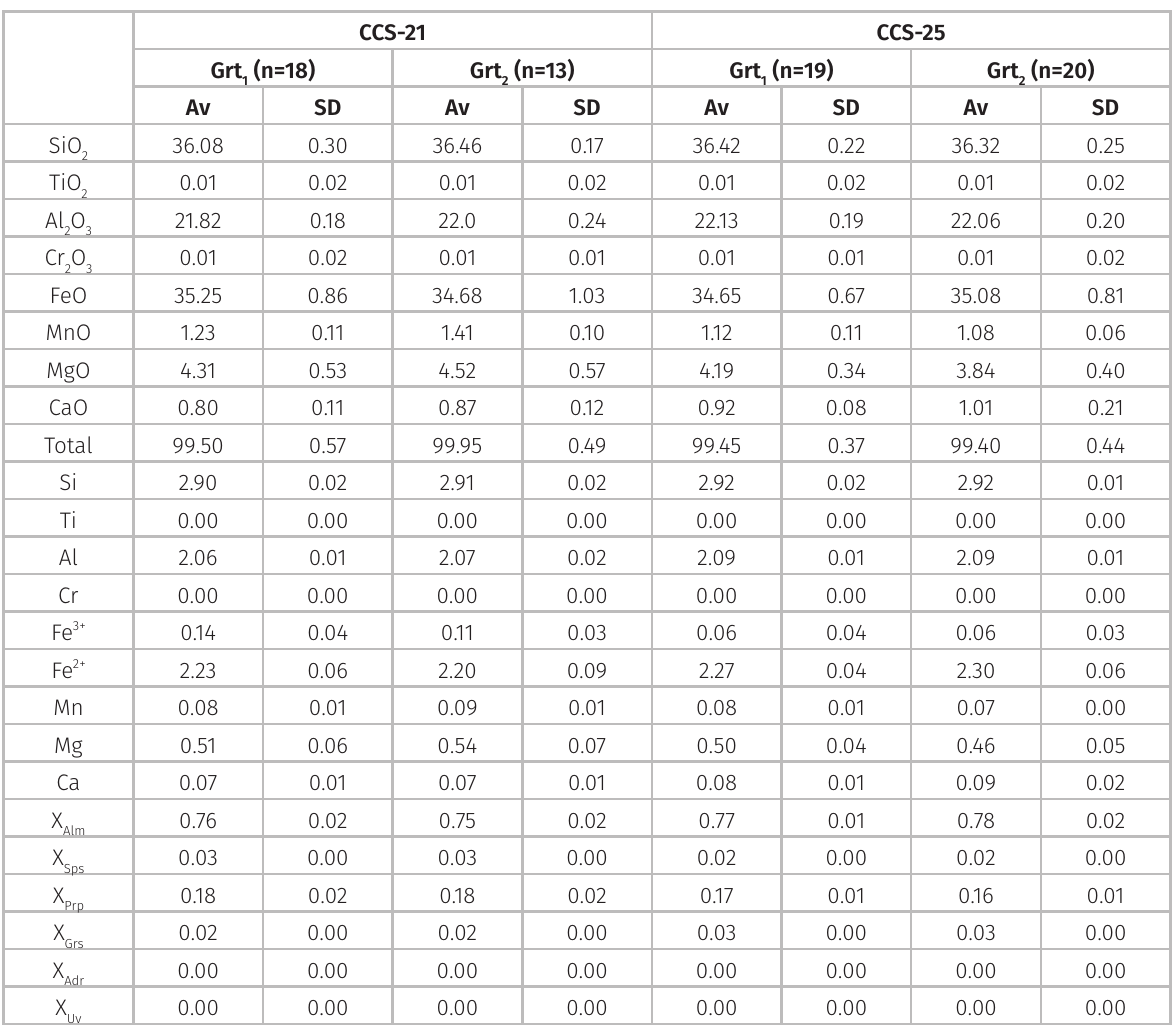
Table I. Average (Av) and standard deviation (SD) of the mineral chemistry of garnets. Calculations based on 12 oxygens, following the methodology of Droop